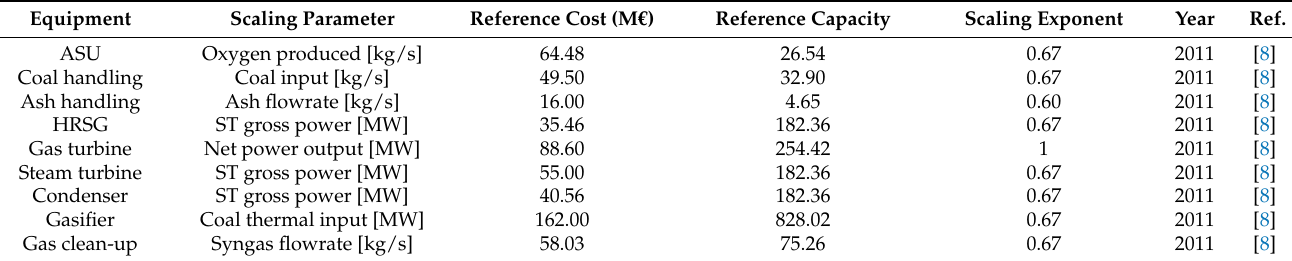
Table 1. Reference costs, capacities and scaling exponents for the case without CO 2 capture used in Equation (9). Equipment